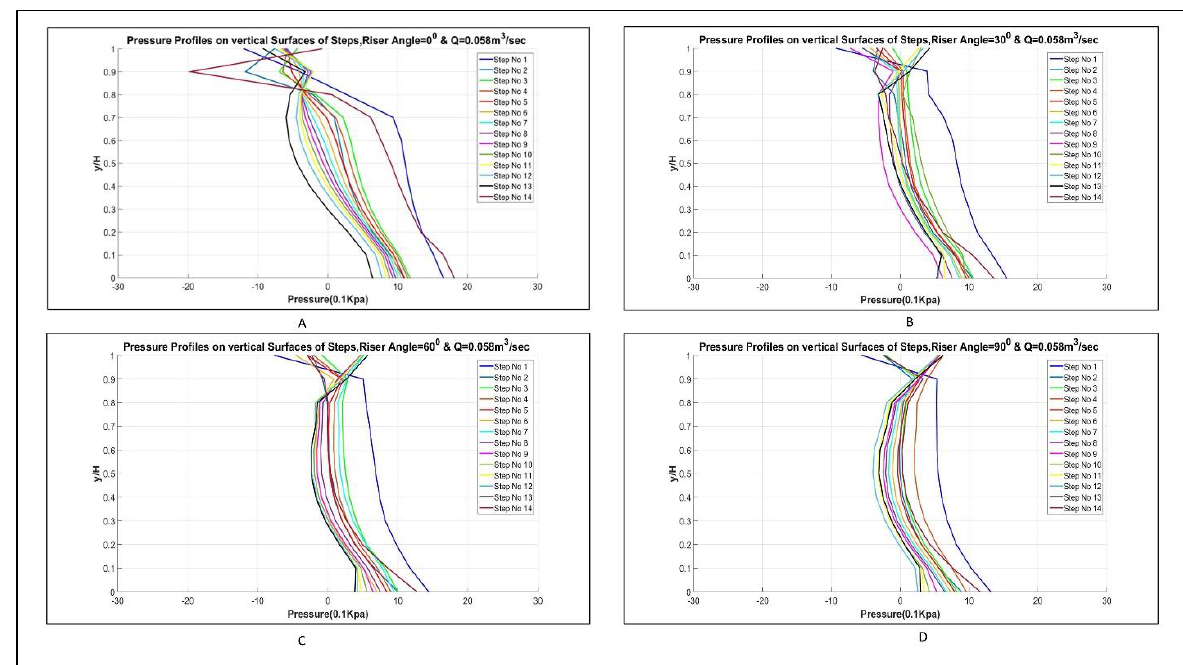
Figure 11. Pressure profiles for ( A ) simple stepped, ( B ) 30°, ( C ) 60°, and ( D ) 90° curved risers spillway for the head of 160 mm.